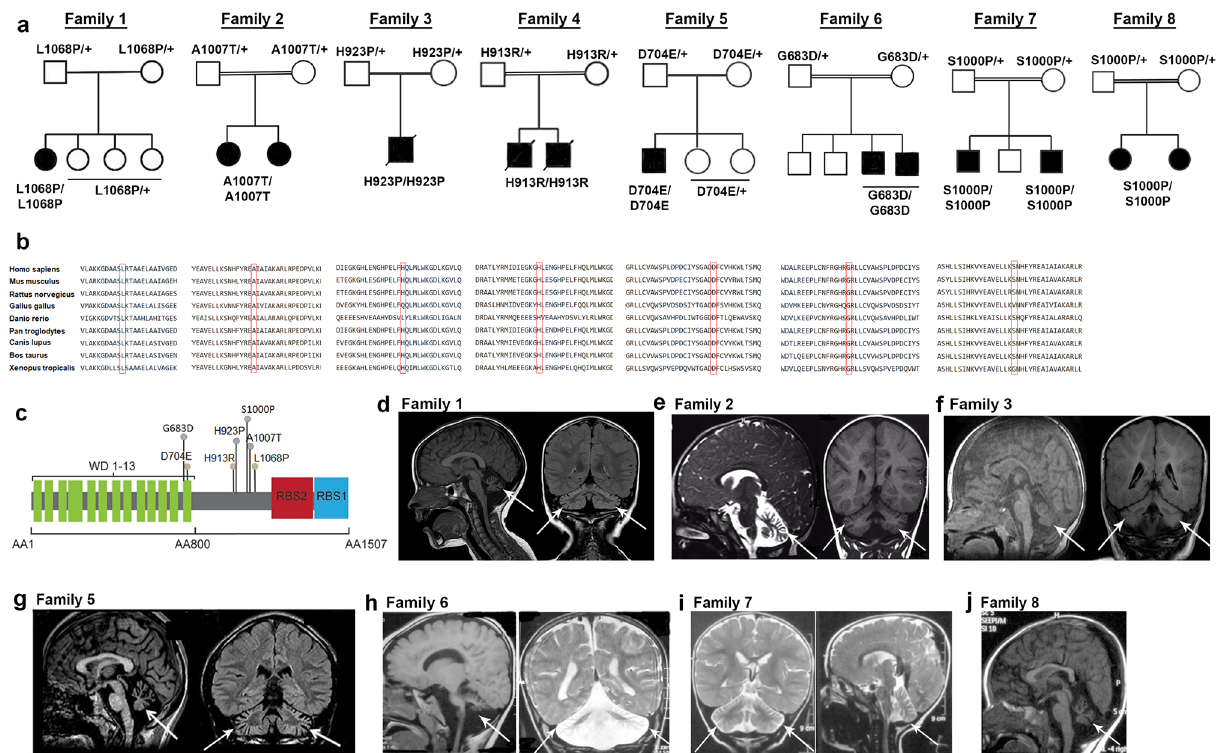
Fig. 1 Variants in GEMIN5 cause developmental delay, hypotonia, motor dysfunction, and cerebellar atrophy. a Pedigree of the patients with homozygous variants in GEMIN5 . Affected individuals who underwent clinical examinations are represented by arrowhead. b Multiple sequence alignment showing conservation of amino acid residues in GEMIN5 (red rectangle) across species . Polyphen-2 analysis predicted probably damaging effect of variants on GEMIN5 structure and function. c Schematic showing functional domains and position of homozygous variants in GEMIN5 protein. d – j MRI scans showing characteristic cerebellar atrophy (white arrow) in patients carrying different bi-allelic variants in GEMIN5 ( + represents wild type allele of